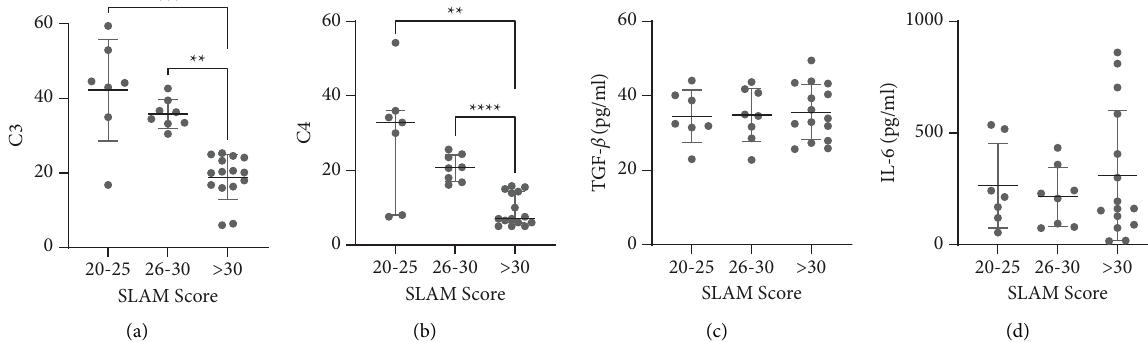
Figure 1: Comparison of complements and cytokines levels among groups of patients with SLE based on their SLAM scores. Te n of each group was: 20–25 � 7, 26–30 � 8, and > 30 � 15. SLAM: systemic lupus activity measurement, C3: complement 3, C4: complement 4, TGF- β : transforming growth factor-beta, and IL: